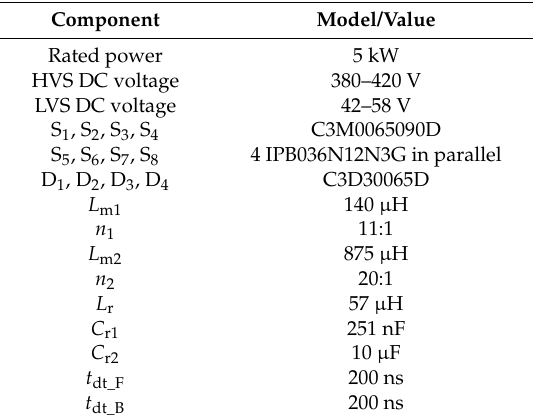
Table 1. Parameters of the converter.